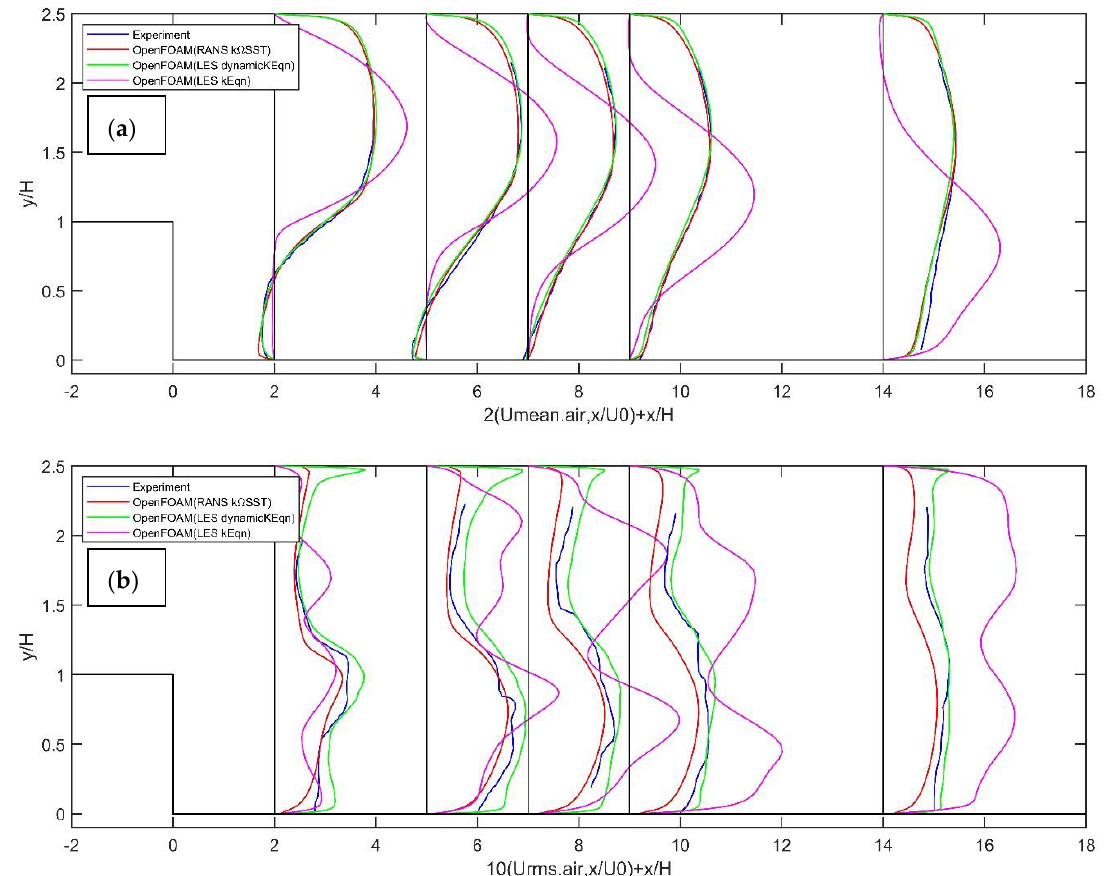
Figure 4. Comparisons of experimental and OpenFOAM simulated streamwise air ( a ) mean and ( b ) fluctuating velocity profiles at the measurement locations under RANS and LES frameworks.